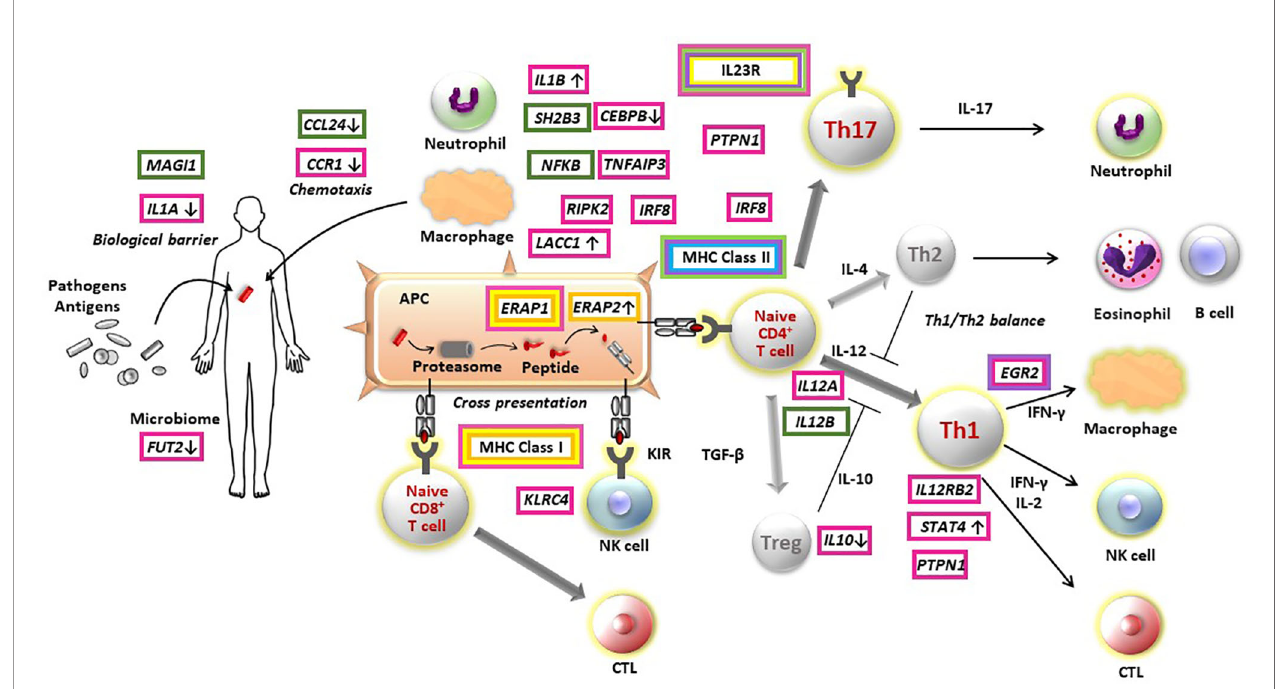
FIGURE 1 | Pathogenesis of non-infectious non-infectious uveitis elucidated by immunogenetic fi ndings. Susceptibility genes of Behc ̧ et ’ s disease (red boxes), sarcoidosis (green boxes), Vogt-Koyanagi-Harada disease (purple boxes), acute anterior uveitis (yellow boxes), birdshot chorioretinopathy (orange boxes), and tubulointerstitial nephritis and uveitis syndrome (light blue boxes) are indicated in the fi gure. The direction on gene expression or function of risk alleles are described with arrows, where identi fi ed. APC, antigen presenting cell; CTL, cytotoxic T cell; NK, natural killer cell; Treg, regulatory T